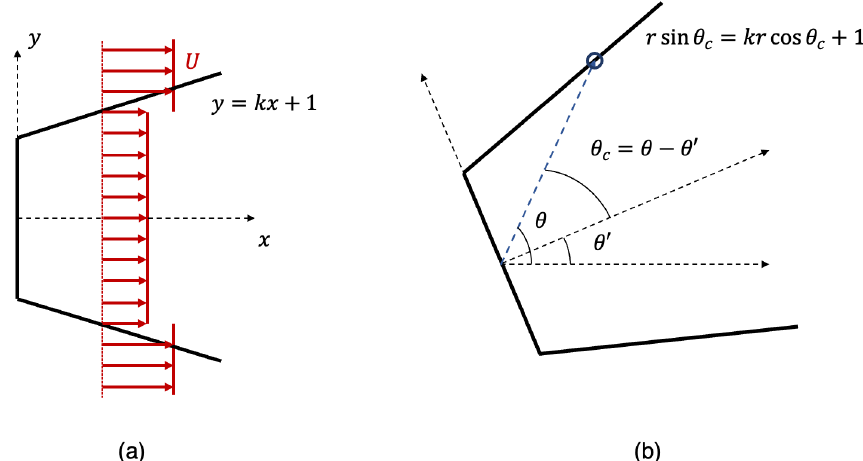
Figure 2. (a) A schematic of the top-hat wake model in Cartesian coordinates with the wind aligned with the x direction. (b) The wake region in polar coordinates, rotated by a wind direction θ (cid:48) , with the wake boundary defined by the angle θ c .